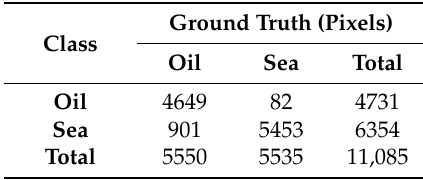
Table 13. Confusion matrix achieved by SVM based on four features derived from local linear embedding (LLE) on quad-pol SAR features.